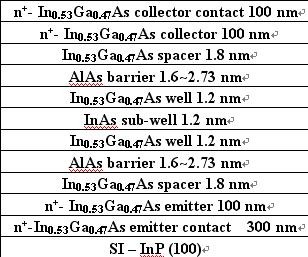
Schematic cross section of an AlAs/In0.53Ga0.47As/InAs RTD.